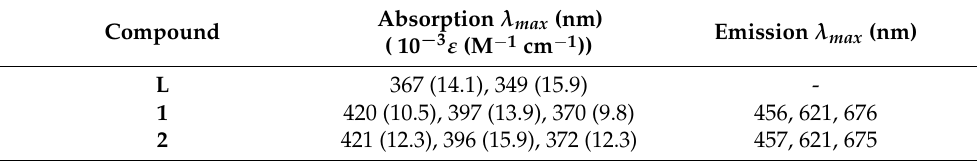
Table 1. Absorption and emission ( λ exc = 418 nm) spectral data of L , 1 and 2 in DMSO. Compound